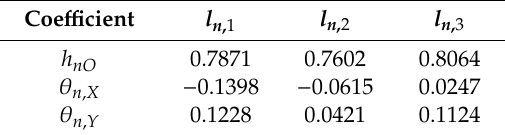
Table 2. Pearson correlation coe ffi